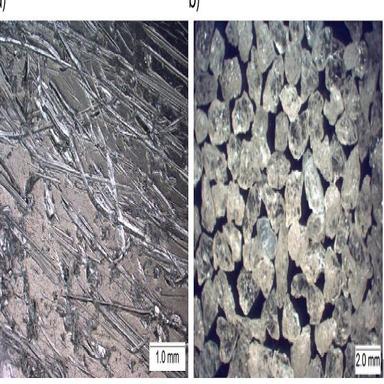
(a) Surface of a polished H13 tool steel test specimen subjected to dry, three-body abrasion plus intermittent impact on a layer of loose, angular alumina particles. Gouges and digs are smaller than the abradant particle diameter, but tiny scratches within those scratches are smaller still. (b) Angular alumina abrasive from the same lot as that which caused the damage shown in image (a).